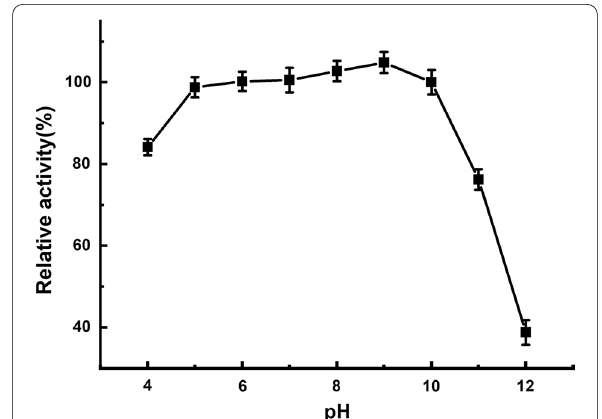
Fig. 4 Effect of pH on the stability of esterase Tan410